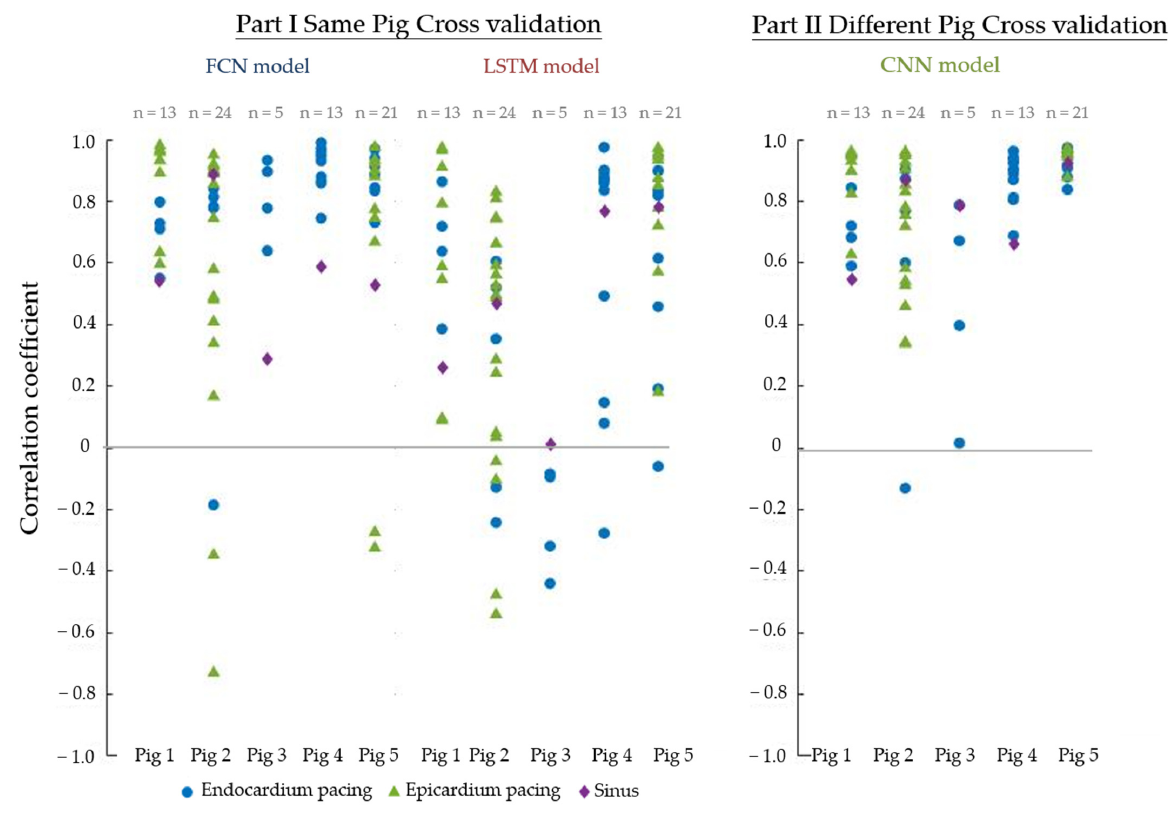
Figure 14. Correlation c oefficients between the activation time maps derived from the recorded data and the reconstructed electrogram. ( Left ): Correlation coefficients of the activation time map for the validation data after cross-validation. ( Right ): Correlation coefficients of the activation time maps of all validation data in the cross-validation. Each dot represents a correlation coefficient between the activation time map from the recorded data and the reconstructed data.